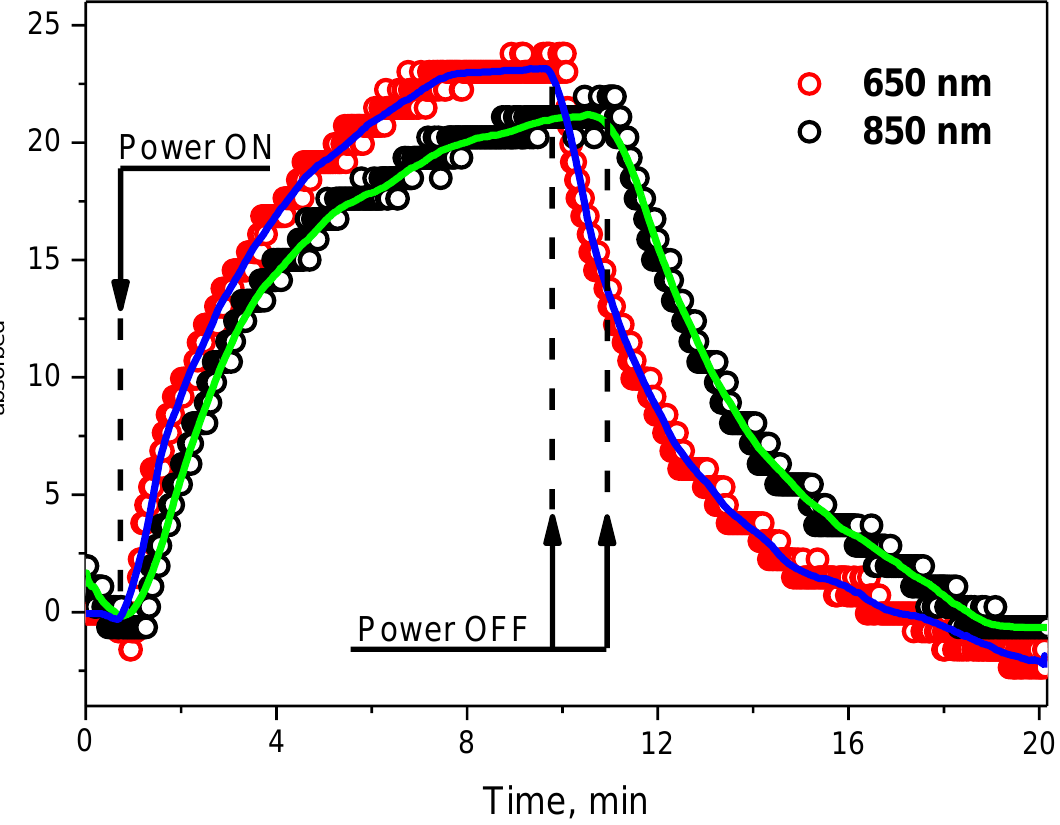
Figure 2. Photoinduced heating/cooling of colloidal solutions of O, N-CDs in water at two laser wavelengths: 650 and 850 nm. Open symbols correspond to experimental points and solid lines to exponential-like fitting curves.